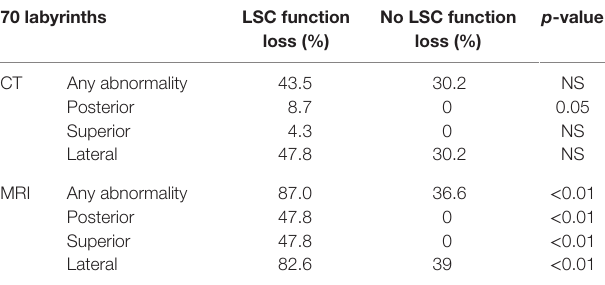
TaBle 3 | correlation between lateral semicircular canal function loss and imaging abnormalities, left and right labyrinths combined. 70 labyrinths